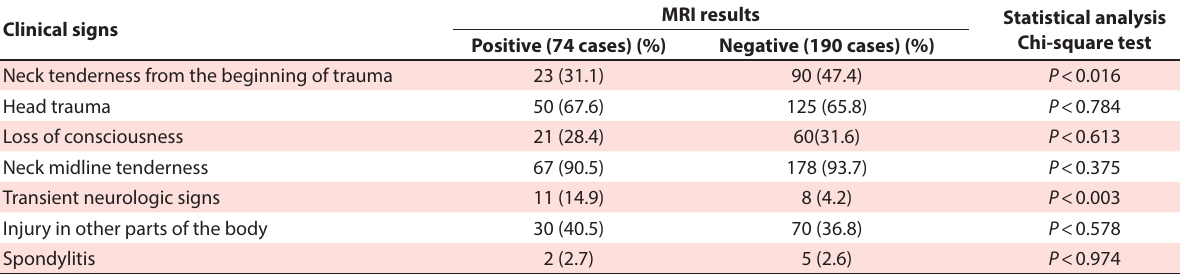
MRI results Statistical analysis